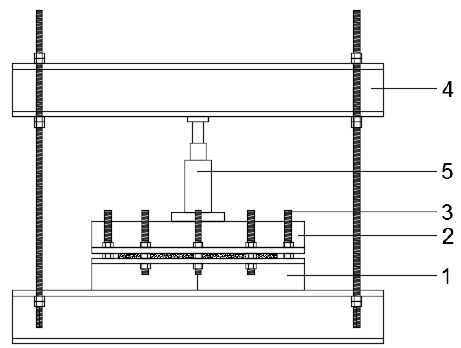
Figure 1. Forming setup of biocomposite boards (BcB): 1—bottom part of mould; 2—upper part of mould; 3—screws; 4—stand; 5—hydraulic jack.